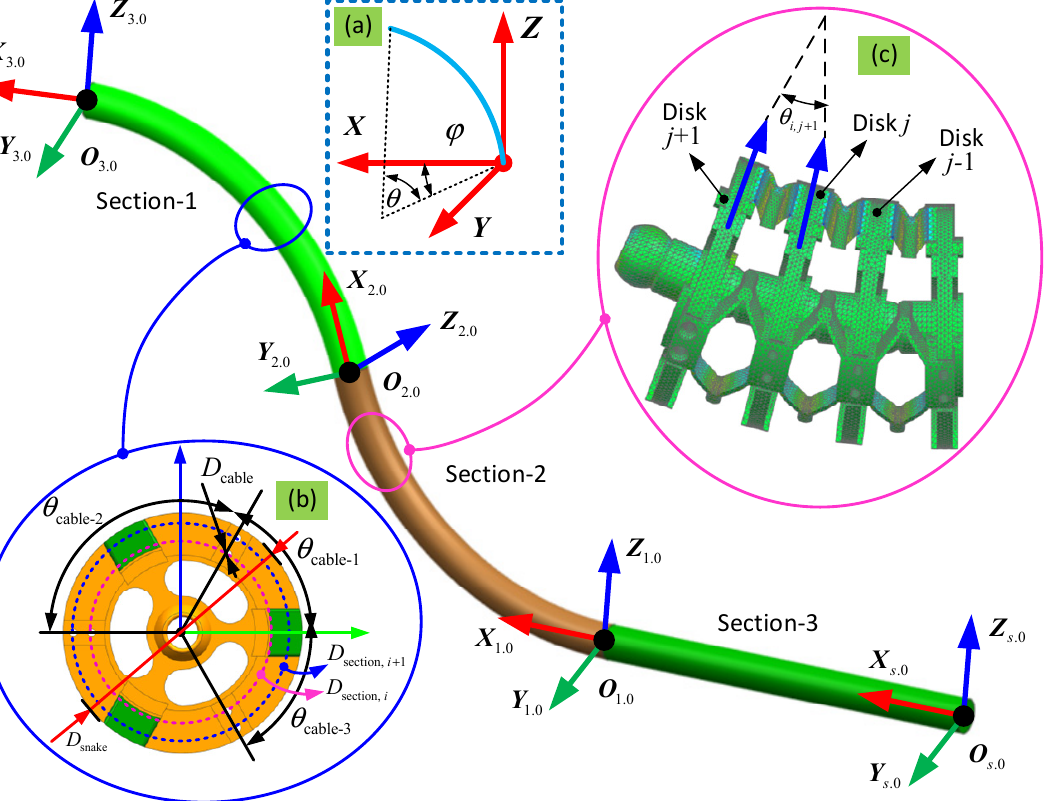
Figure 3. Kinematic definition of the continuum robot formed by three sections: ( a ) definition of the bending and phase angles, which are parameters for the constant curvature bending model of each section; ( b ) section view of a typical disk that makes up each segment; ( c ) kinematic relationship of adjacent disks within each section.